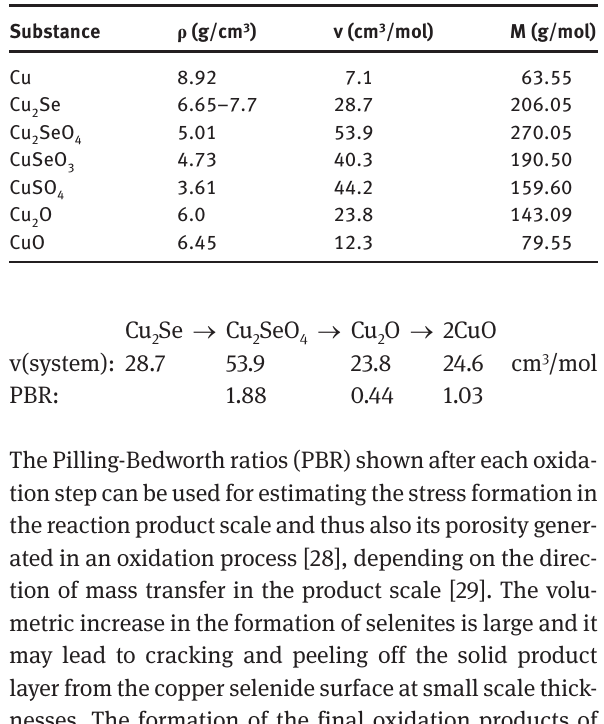
Table 1: Density ( r ), molar volume (v) and molecular weight (M) of selected substances at room temperature [25,